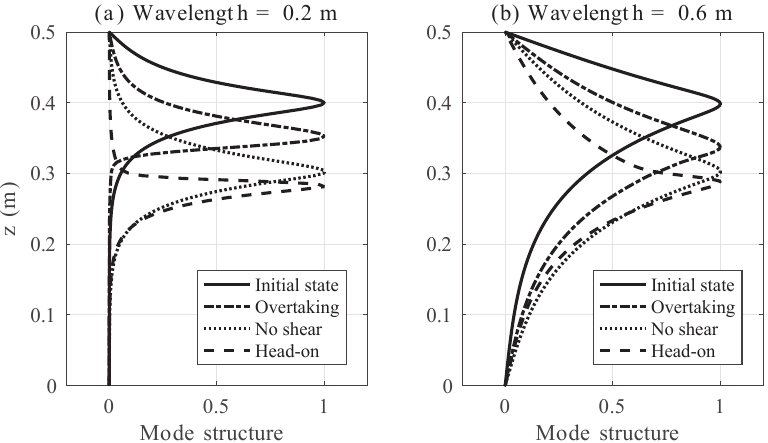
Figure 7. Vertical structure profiles of the linear waves with wavelengths of (a) 0.2m and (b) 0.6m in the initial, undisturbed state (solid curve) and the ISW-induced background state with an overtaking collision (dot-dashed curve), a head-on collision (dashed curve), and a hypothetical zero-background current (dotted